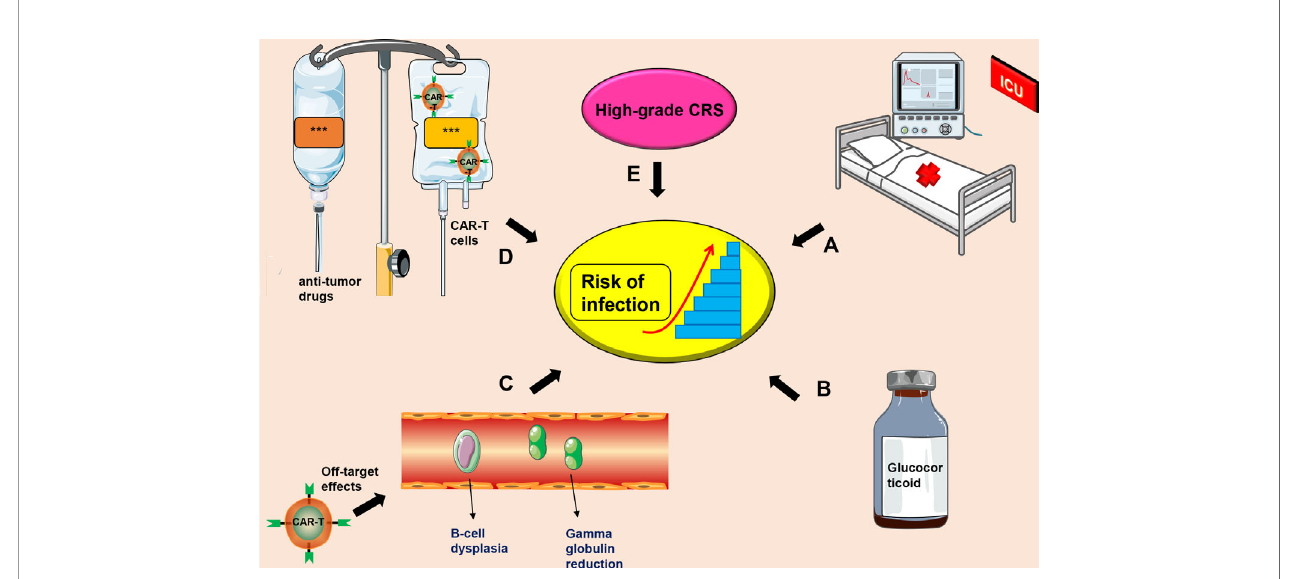
FIGURE 2 | Factors that induce CIT. (A) Severe CRS patients receiving further treatment in the ICU, which increases the risk of infection; (B) Long-term administration of high-dose use of glucocorticoids; (C) Off-target effects of CAR-T cell therapy may cause B-cell dysplasia and hypogammaglobulinemia; (D) A combination of anti-tumor drugs and CAR-T cells; (E) High-grade CRS. This symbol *** only represents drug information or patient